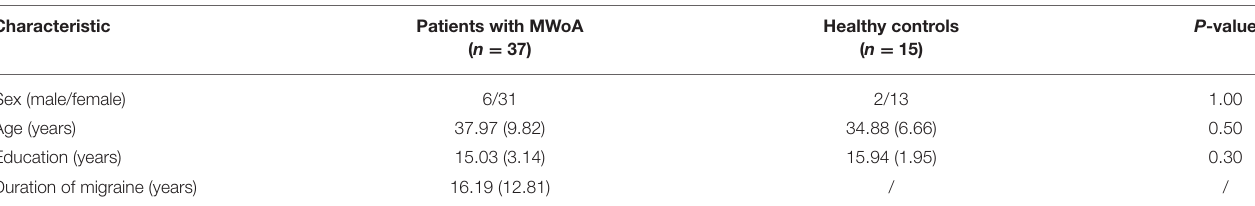
TABLE 1 | Clinical characteristics of patients with migraine without aura and healthy controls. Characteristic Patients with MWoA